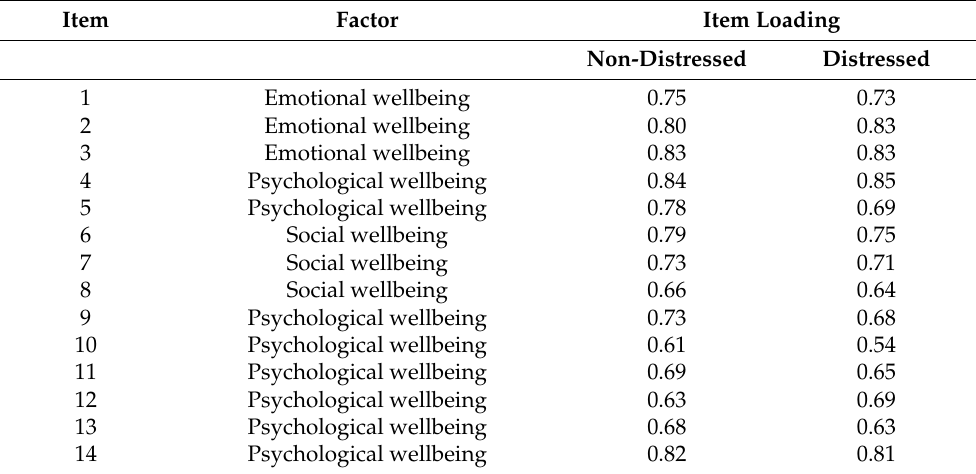
Table 4. Item loadings onto the modified EFA MHC-SF factor structure for the highly distressed and non-distressed groups.